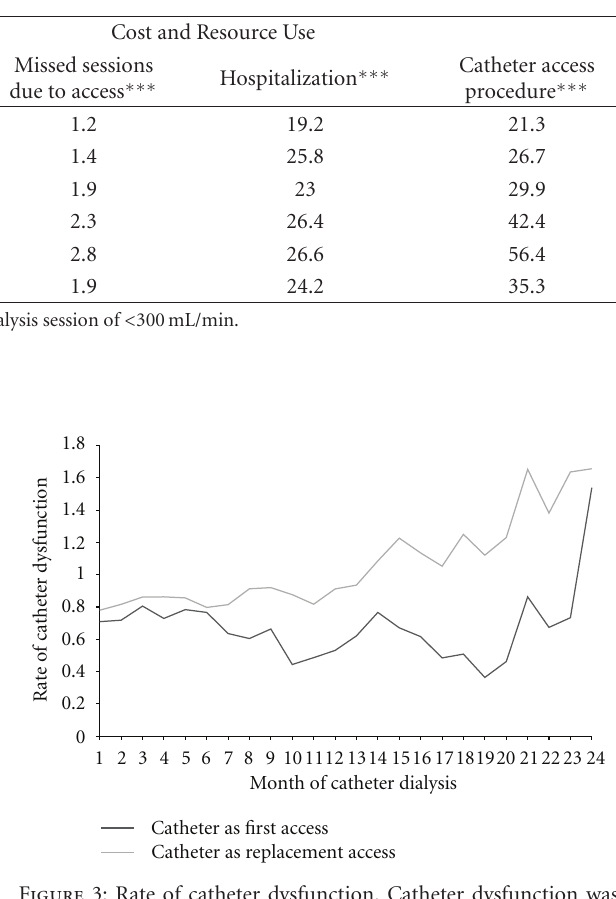
Table 4: Cost and resource use by number of catheter dysfunction sessions ∗ .